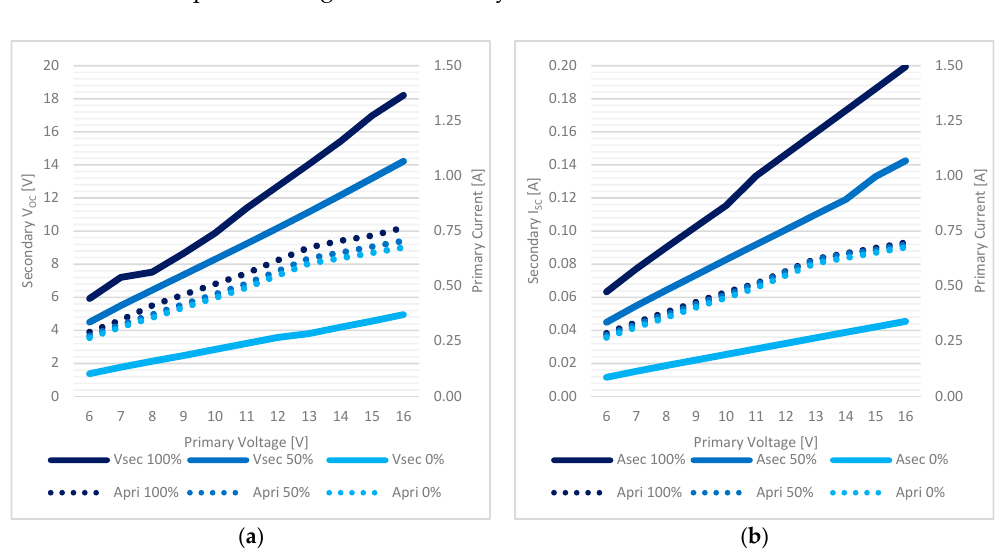
Figure 13. Inductive charging system test setup, concrete environment: ( a ) is the test bench set-up, including the required instrumentation; and ( b ) is a picture of the set-up of the coils. At 15 cm @ 12 V PRI (coaxial coils), a V OC of 12.722 V is measured in the case of transmission in